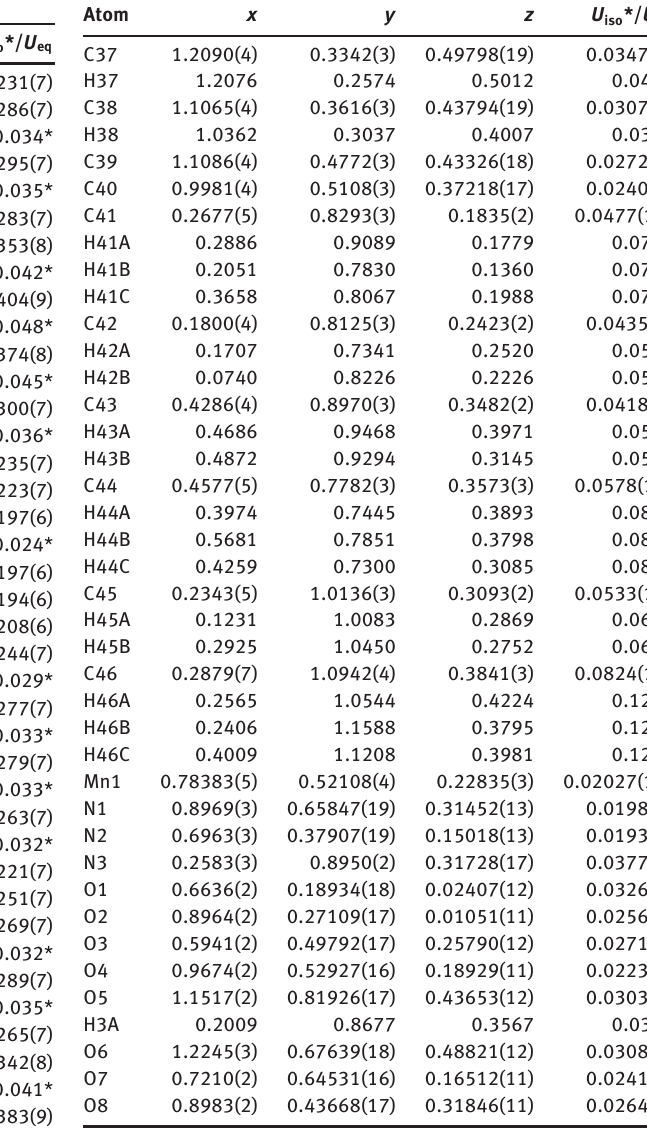
Table 2: Fractional atomic coordinates and isotropic or equivalent isotropic displacement parameters (Å 2